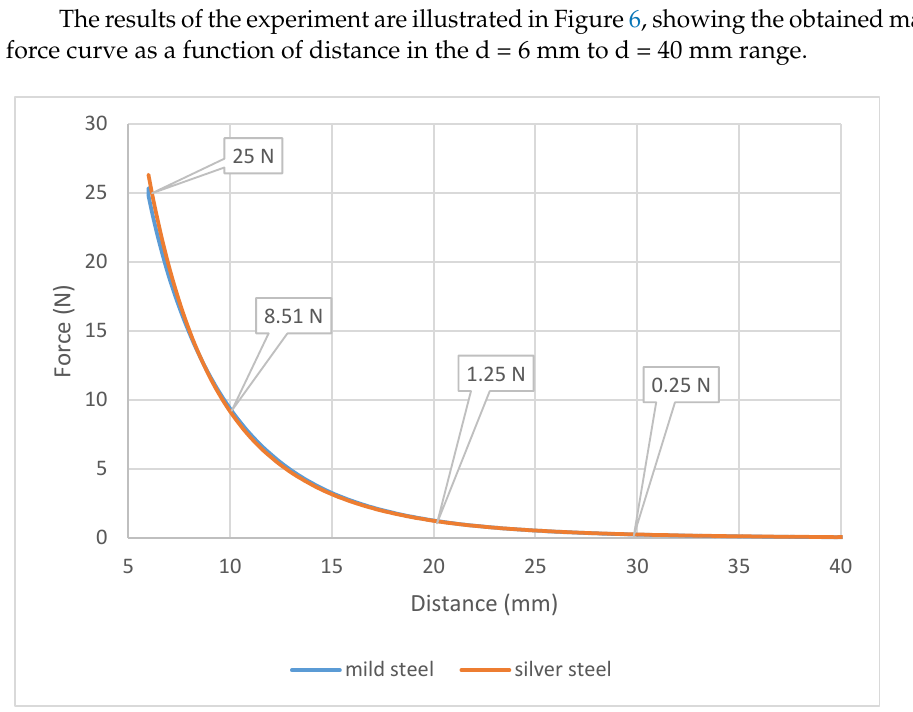
Figure 6. Magnetic force curve as a function of distance between a 24 kg pull-force N52 neodymium magnet and a sliver steel or mild steel target specimen with the same dimension.